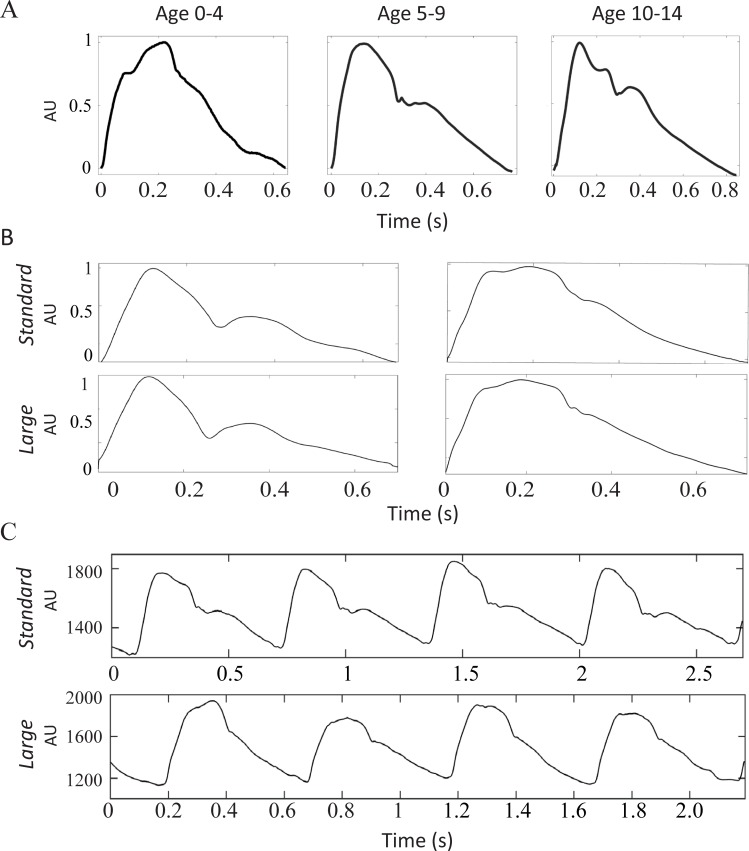
Examples of carotid waveforms collected by Vivio.(A) Examples of waveforms from three different age groups collected by Vivio (left: 0–4, middle: 5–9, right: 10–14). (B) Comparison of waveforms collected by both standard (upper row) and large (lower row) on the same patients (each column is a different patient). (C) Examples of multiple cycle tracings collected by a standard head (top row) and a large head (bottom row) in two different patients. AU is arbitrary unit.